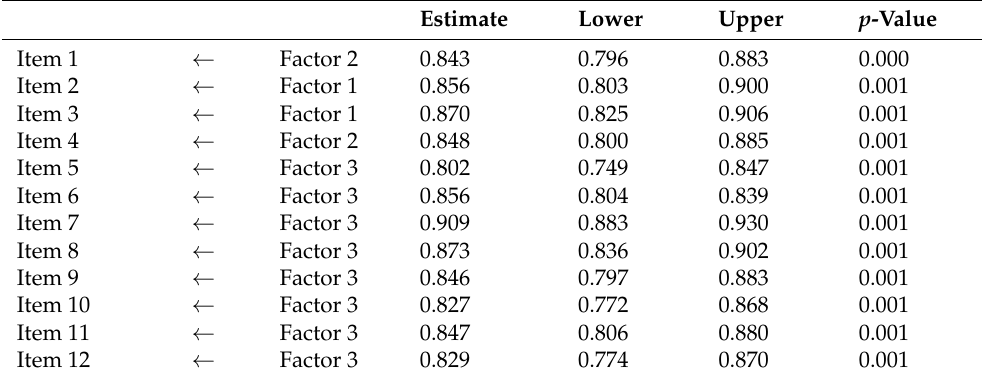
Table 4. Standardized regression weights for the three-factor SLS-12 model (95%